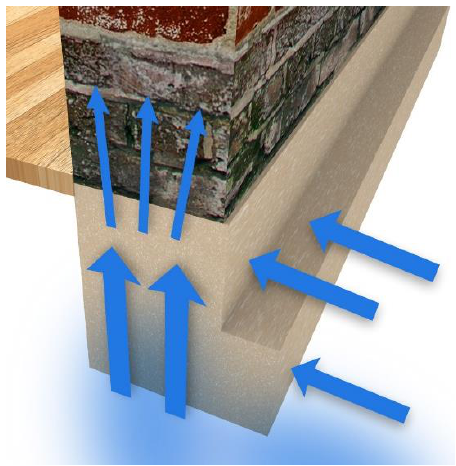
Figure 1. The rising moisture resulting from the direct connection of soil with masonry [14].